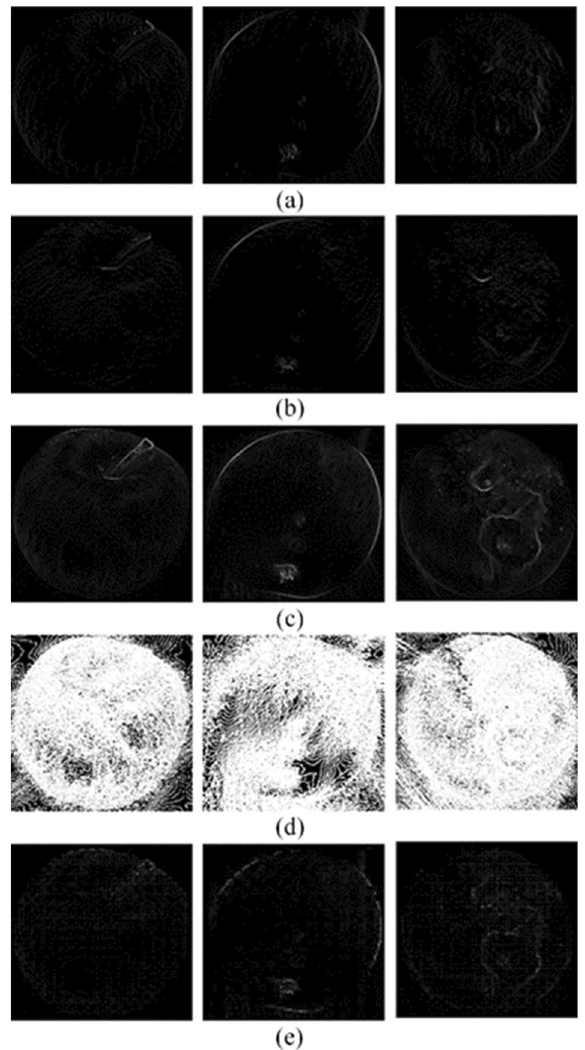
Figure 12. The results of structural feature extraction using HOG for apple images: ( a ) x-direction gradient; ( b ) y-direction gradient; ( c ) gradient magnitude; ( d ) gradient direction; ( e ) HOG